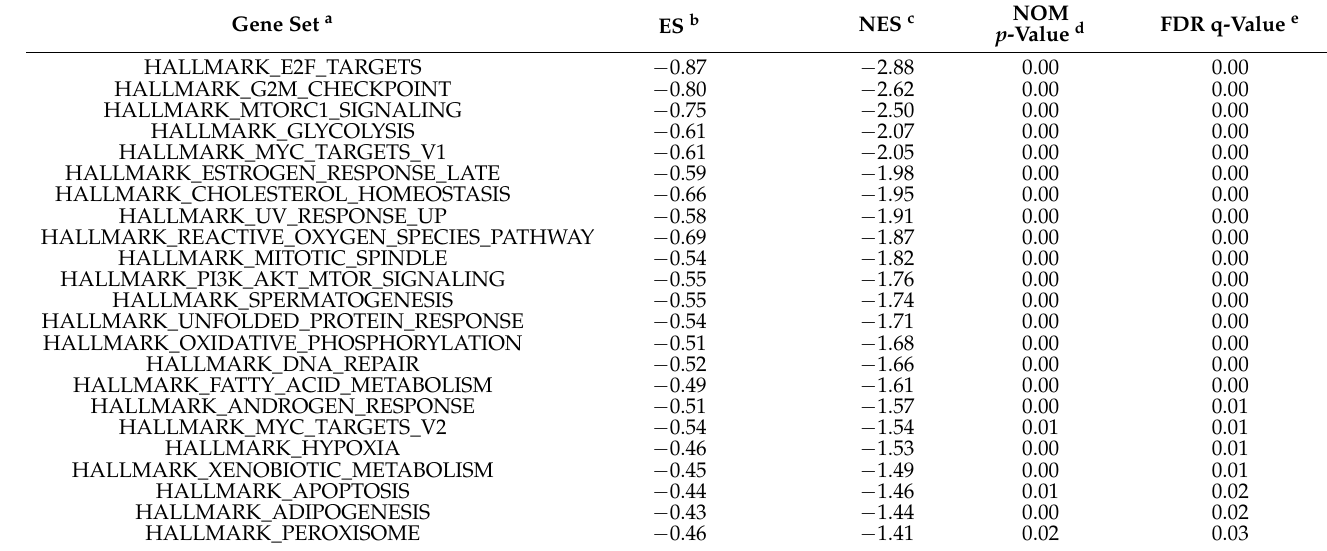
NOM FDR q-Value e p -Value d